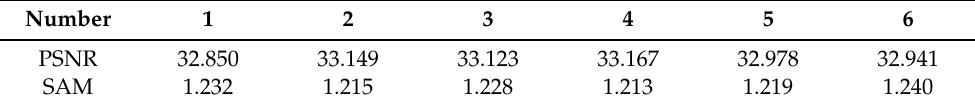
Table 2. PSNR and SAM of SSRN with different numbers of residual blocks on the WDCM